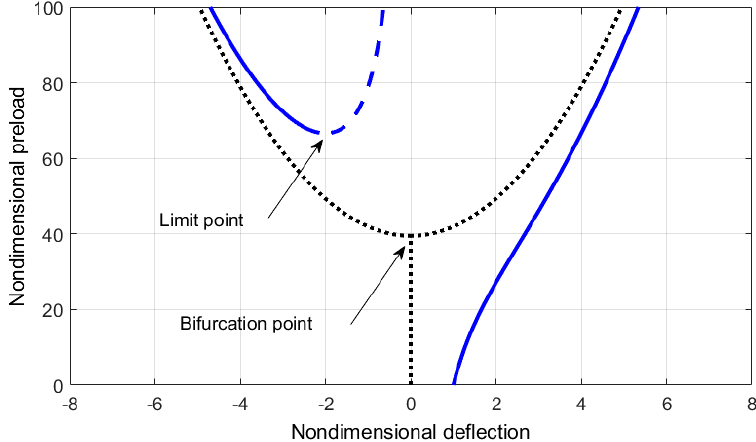
Figure 4. Variation of the static deflection with the pre-load at 𝑎 = 1,𝜇̅ = 0.0 and 𝛼 = 1 .